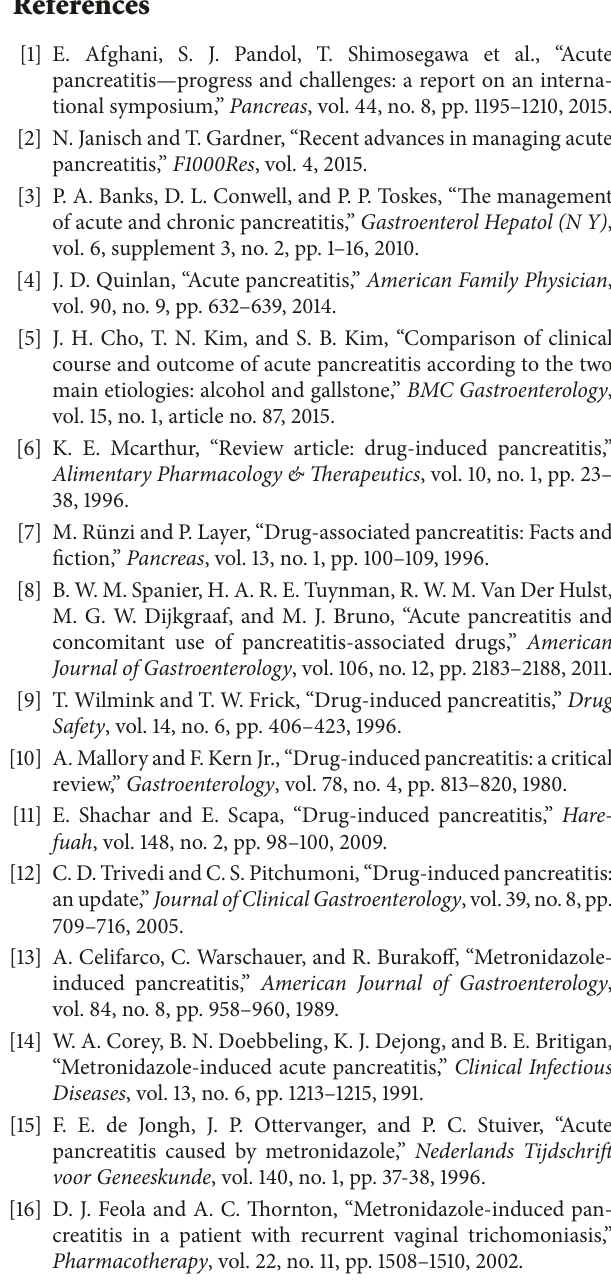
Flow chart 1. Article selection process. (Supplementary Mate-